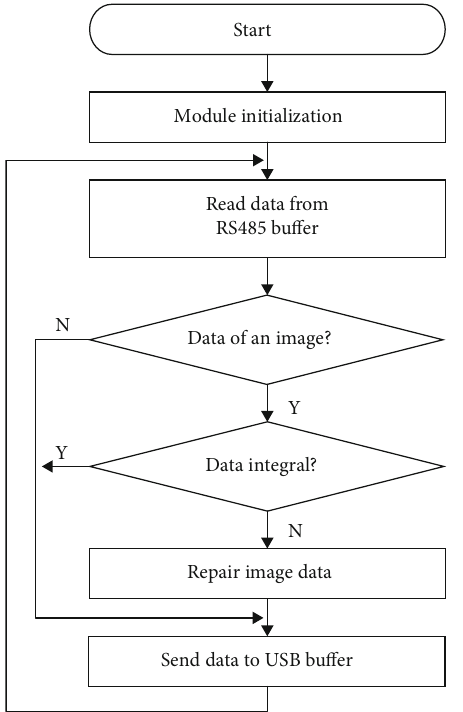
Figure 7: Flow chart of the master computer.